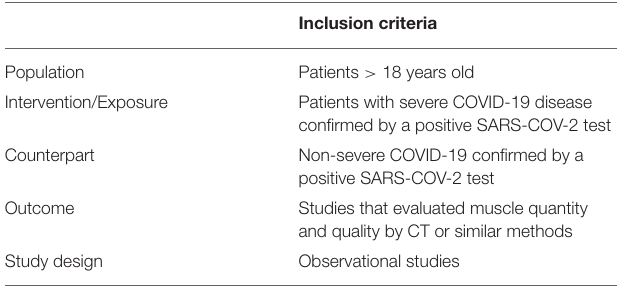
TABLE 1 | Inclusion and exclusion criteria performed by patient, intervention, comparison, and outcome (PICOS)